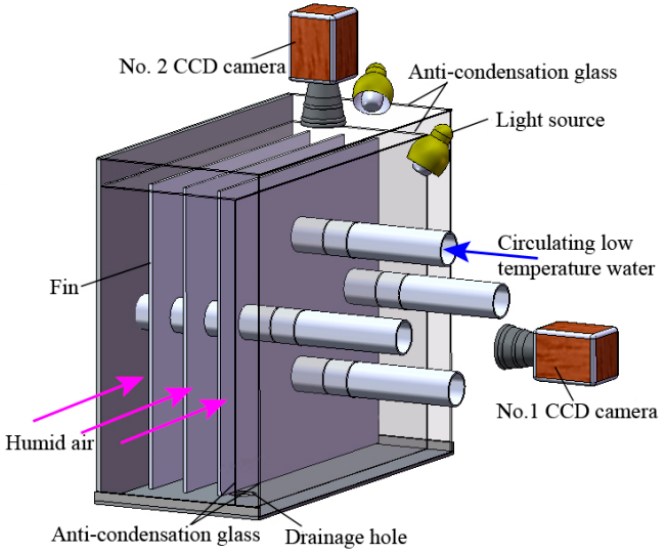
Figure 2. Test specimens: ( a ) copper fin, ( b ) aluminum fin, ( c ) aluminum fin with a hydrophilic layer.